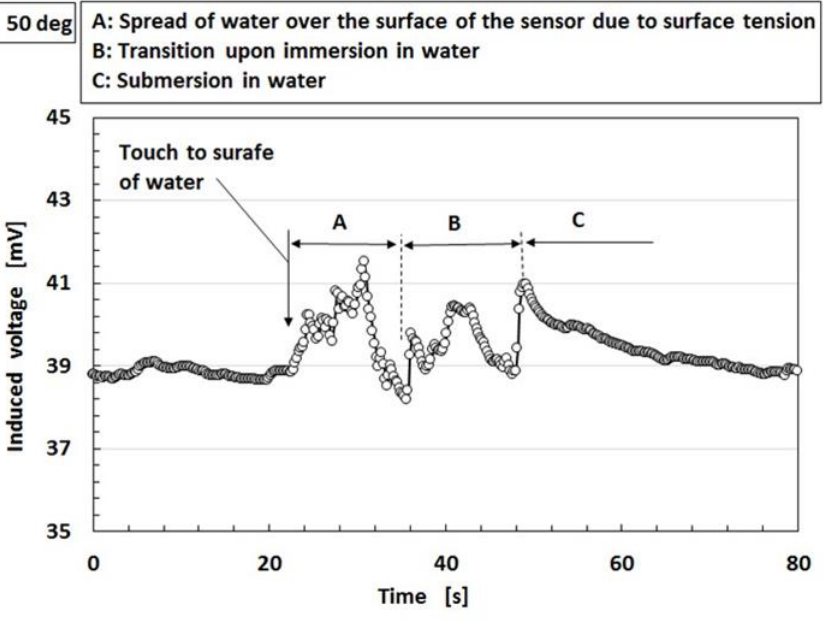
Figure 16. Change of induced voltage when in contact with water.